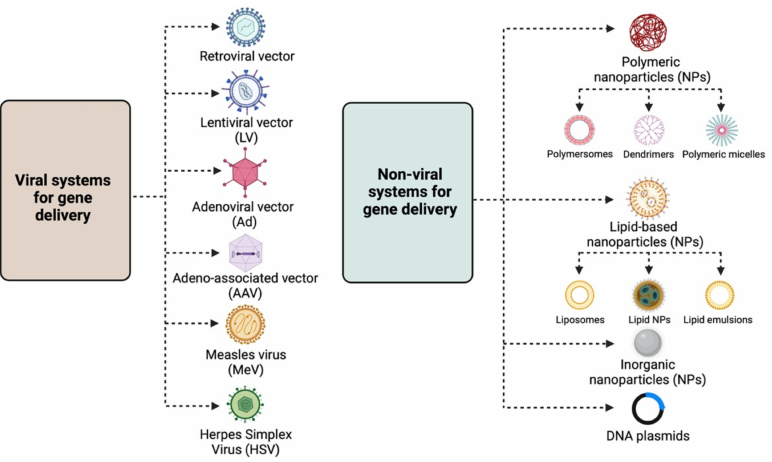
Figure 1. Viral and non-viral systems for gene delivery.